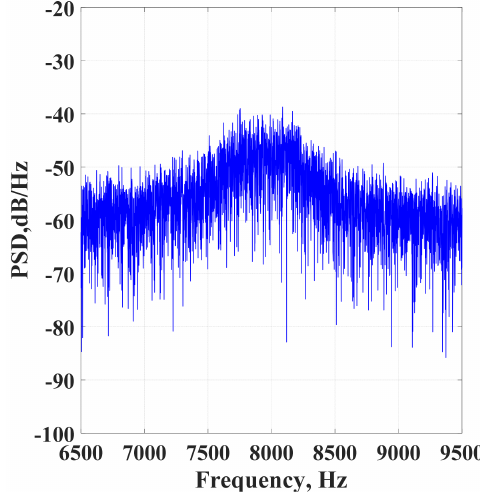
Figure 8. The sideband current harmonics with random